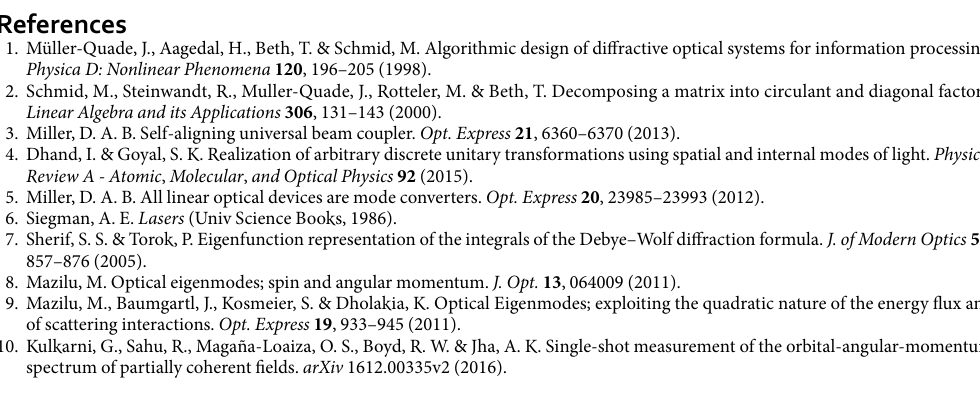
a standard amplitude and phase modulation setup using a dual head reflective spatial light modulator (SLM, Holoeye HEO 1080 P), and imaged using a magnifying telescope onto the SLM of the eigenmask in the second section of the beam path. The active area of the beam creation SLM (A-SLM1 and P-SLM1 combined) and the focal lengths are chosen such that the beam illuminates a significant area of the eigenmask SLM (A-SLM2 and P-SLM2 combined). Before the eigenmask can be calculated for SLM2, the optical system must be characterized for each of the input beams. To this end an image stack is acquired while a sequence of 1800 probe masks is displayed on SLM2 for each of the input beams. Each of the 1800 beams are interfered with a reference beam, enabling the measure of the relative phase and amplitude of the beam created be each probe mask 32 . The probe masks are chosen so that the image plane field at the CCD can be readily calculated for any linear combination of probe masks and for any input beam. Consequently, the eigenmask is calculated as defined above. The procedure is demonstrated with four orthogonal Laguerre Gaussian beams having p -numbers 0 and 1, and  -numbers 0 and 1. Four points on the active area of the CCD are chosen as the target detectors. Figure 4 shows the obtained eigenmask respectively in the spatial and in the spatial frequency domain. It can be noticed from Fig. 4(a) that the mask has only significant values in a central circular area around the beam waist of the four input beams. Less structure can be seen in the phase of the eigenmask. Figure 4(b) shows the Fourier transform of the eigenmask, only 1800 (60 × 30) non-zero values are present since the Fourier components were chosen as probes. Four different regions, corresponding to the four detector points can be discerned in the Fourier trans- form of Fig. 4(b). Figure 5 shows the experimental images obtained when loading the eigenmask on SLM2, and recording the image plane intensity for the four input beams. The experimental results can be seen to fit well with the semi-theoretical calculations with modest drift due to mechanical instabilities in the optical path. As a result, some crosstalk should be expected between the detectors (see Supplementary Material).